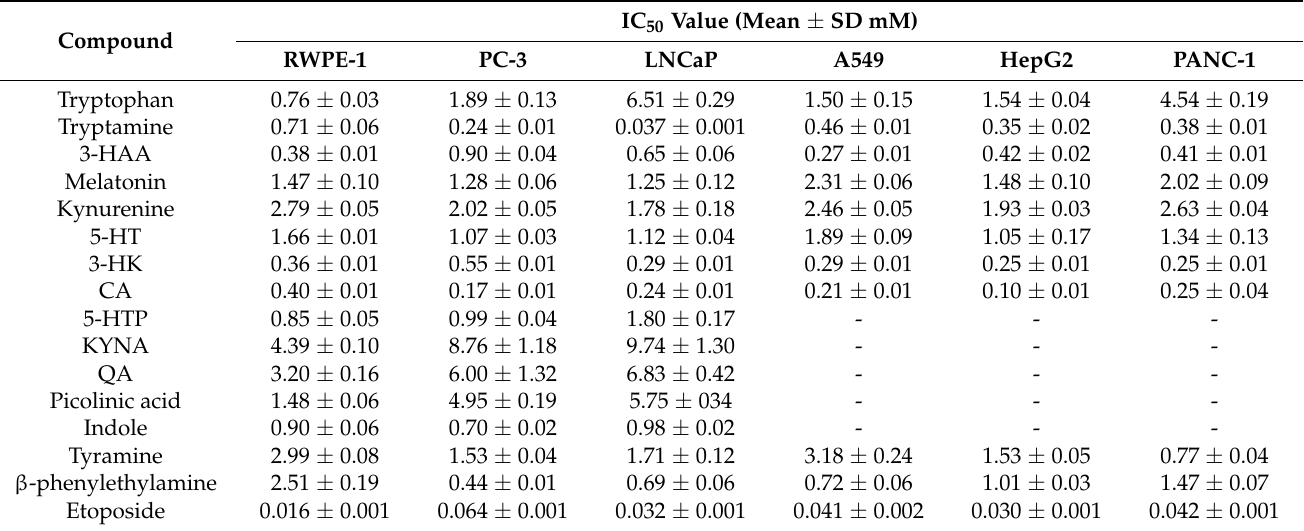
Table 1. Cytotoxicities of studied endogenous metabolites in six cell